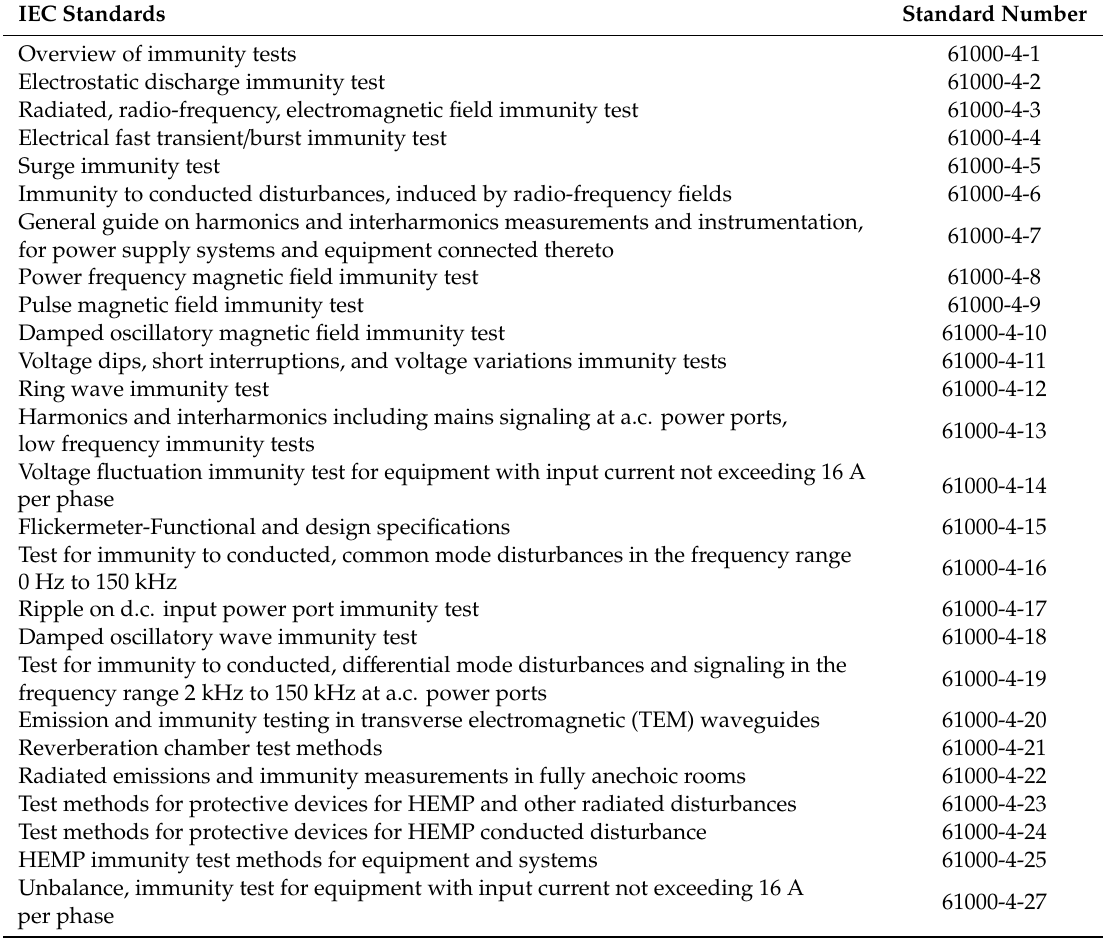
Table A1. Electromagnetic compatibility immunity test and measurement technology series